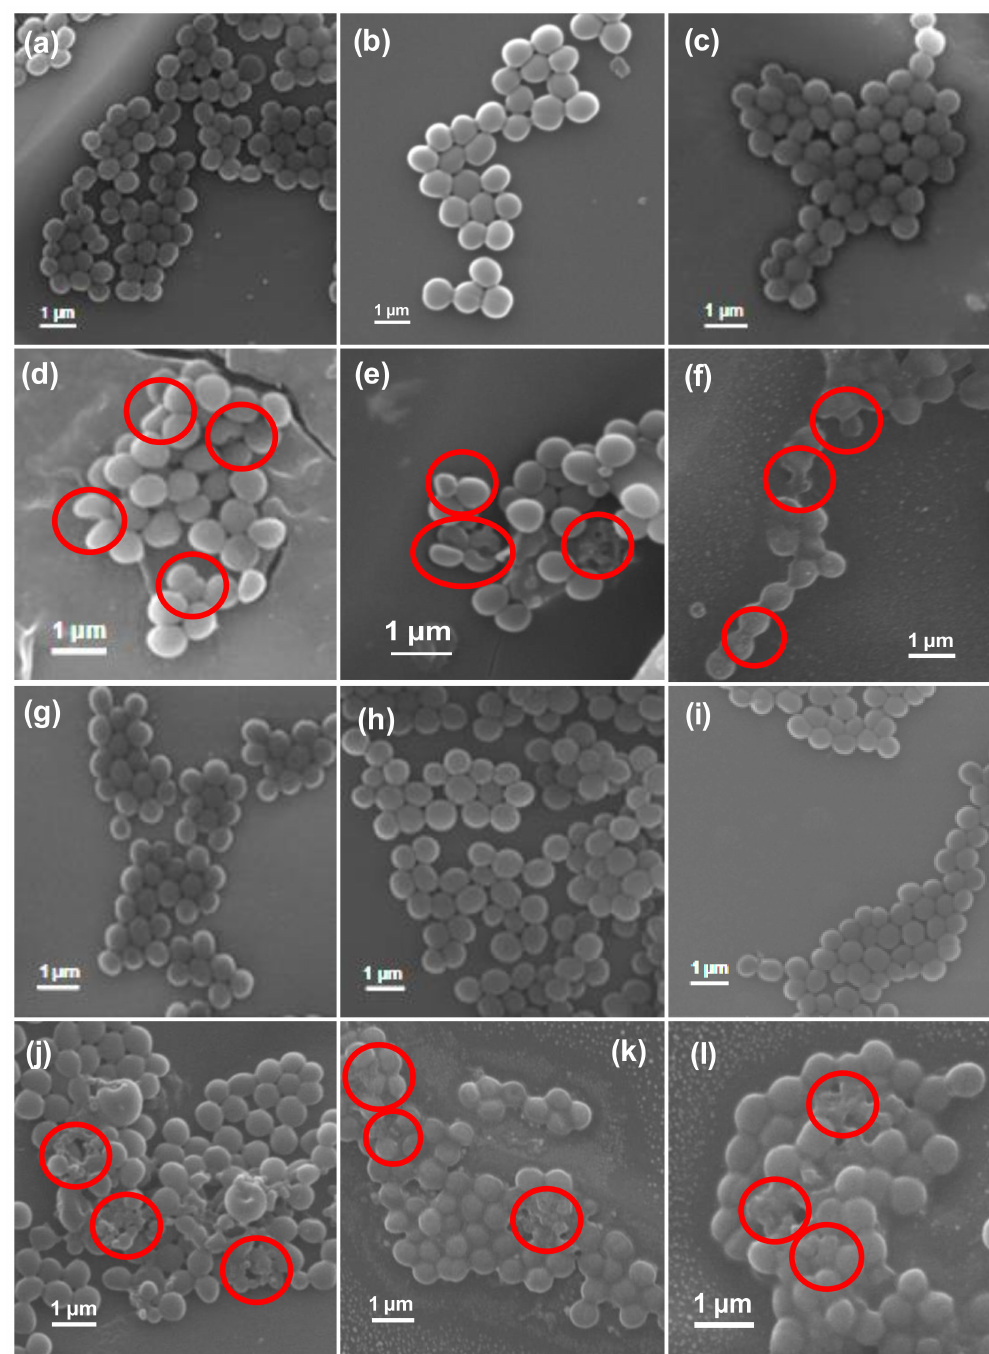
Figure 7. Scanning electron microscopy (SEM) images of bacterial cells. Samples of untreated MRSA1 ( a ), MRSA2 ( b ), MRSA4 ( c ), MRSA6 ( g ), MRSA7 ( h ), MRSA8 ( i ), and treated MRSA1 ( d ), MRSA2 ( e ), MRSA4 ( f ), MRSA6 ( j ), MRSA7 ( k ), and MRSA8 ( l ) with AZE3. Red circles indicate areas of cell membrane